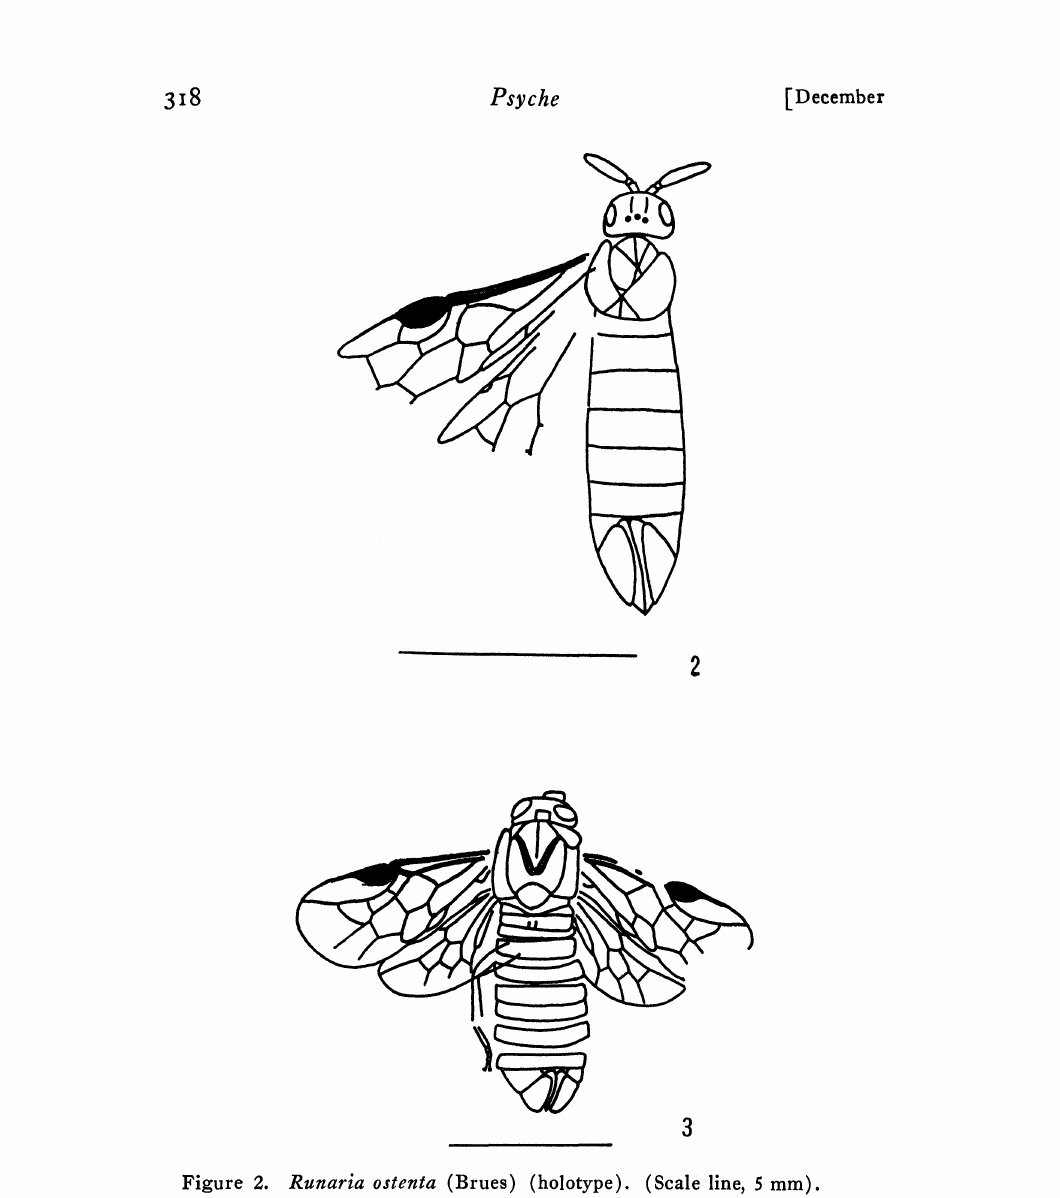
Figure 2. Runaria ostenta (Brues) (holotype). (Scale line, mm). Figure 3. 8terictilhora konoi (Rohwer) (holotype). (Scale line,